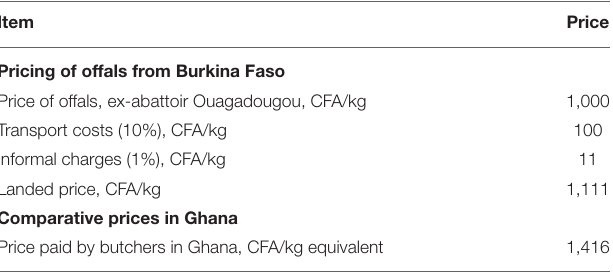
TABLE 5 | Comparison of potential Burkinabe offal export prices and Ghanaian domestic prices.